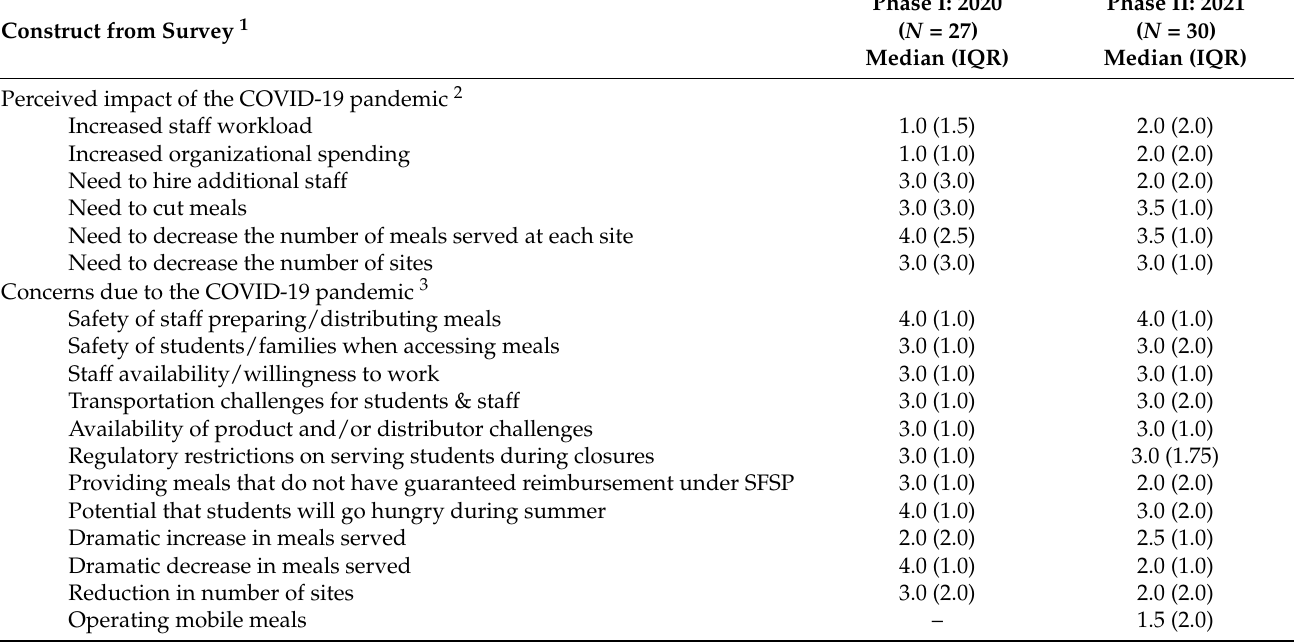
Table 2. Sponsor responses to survey items regarding their perceived impact of and concerns due to the COVID-19